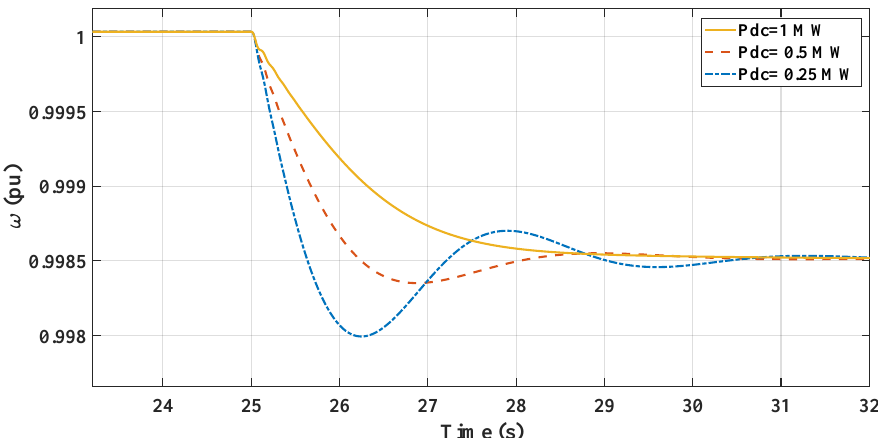
Figure 16. Frequency Response at different DC-microgrid